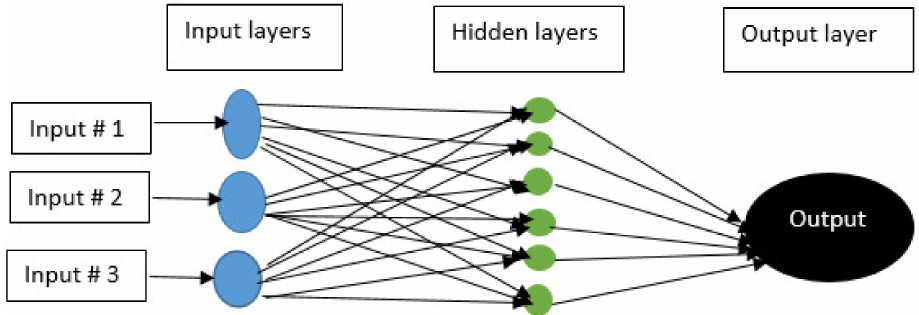
Figure 3. The basic structure of artificial neural network (Source: https://data-flair.training/blogs, accessed on 25 October